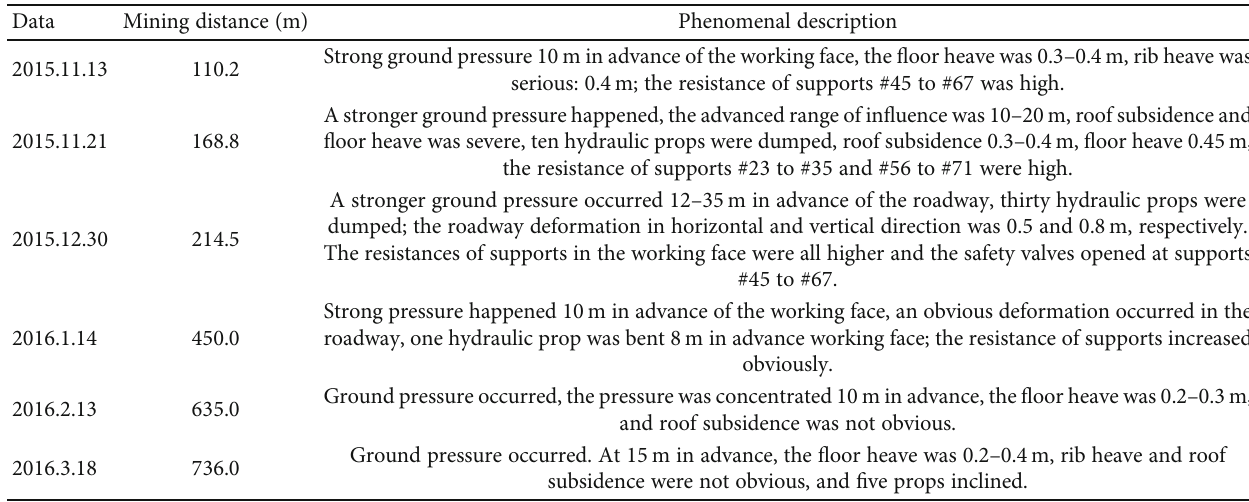
Figure 1: Caving mining method and strong ground pressure in the working face. Table 1: Statistics of the strong ground pressure on the working face.